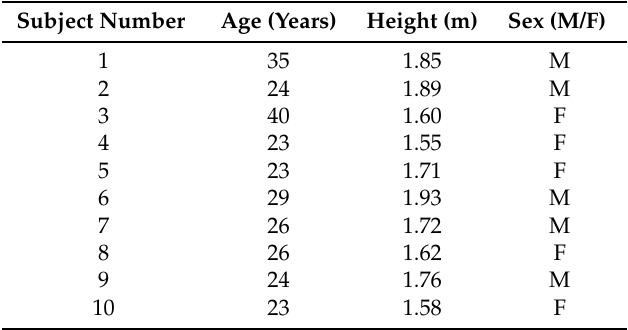
Table 1. Characteristics of study participants.